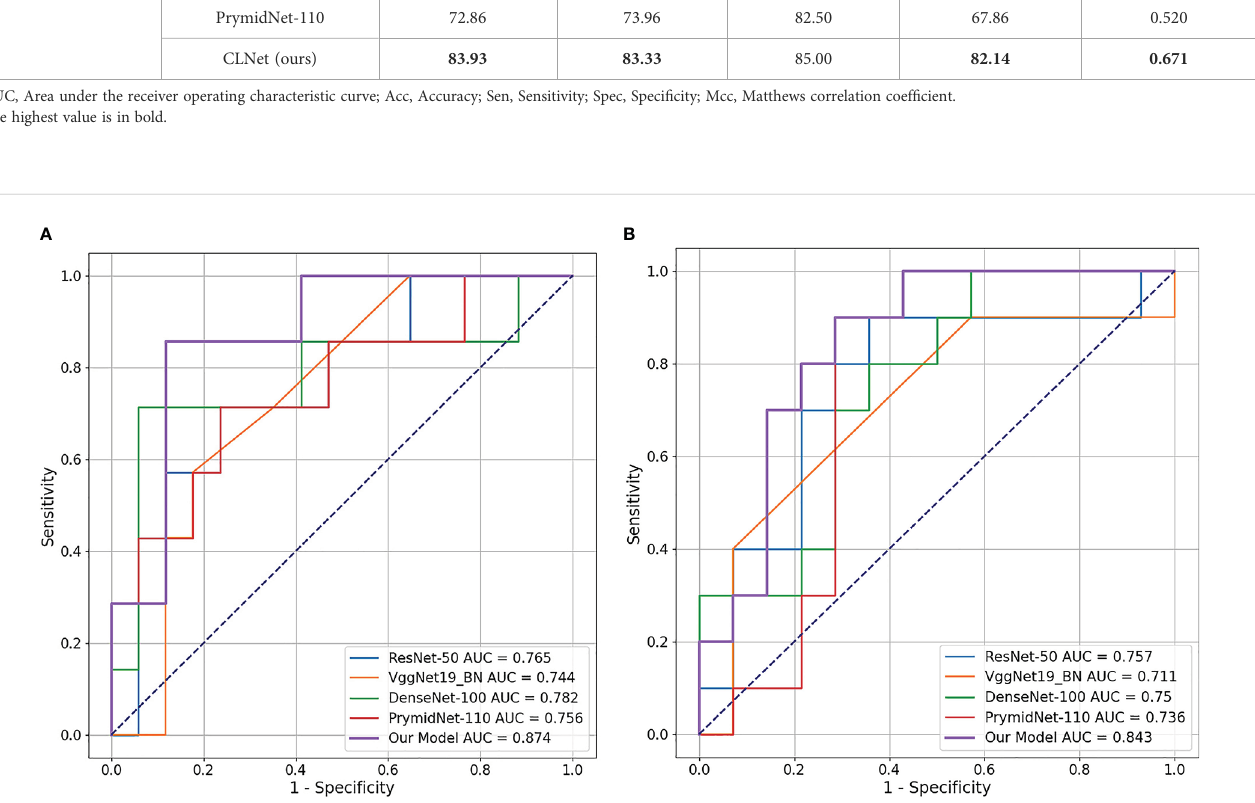
FIGURE 4 Receiver operating characteristic (ROC) curve of the four DL models and proposed CLNet. Our CLNet achieves the best performance in both PD-1 and PD-L1 prediction tasks. (A) denotes PD-1 expression and (B) denotes PD-L1